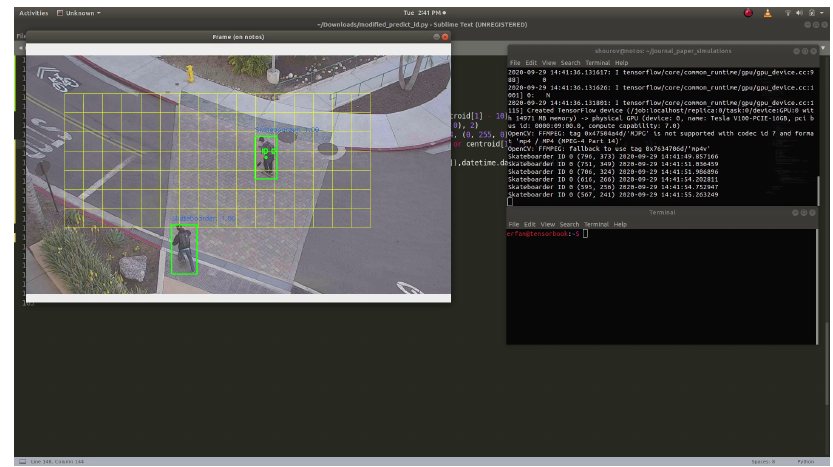
Figure 27. Automated collection of information for PET on the terminal.